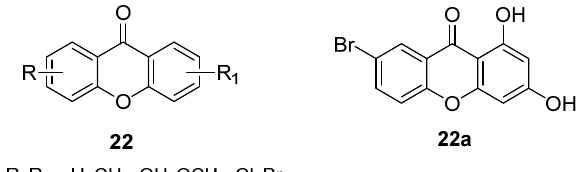
Figure 17. Novel antitumour xanthones for DMXAA combinations.